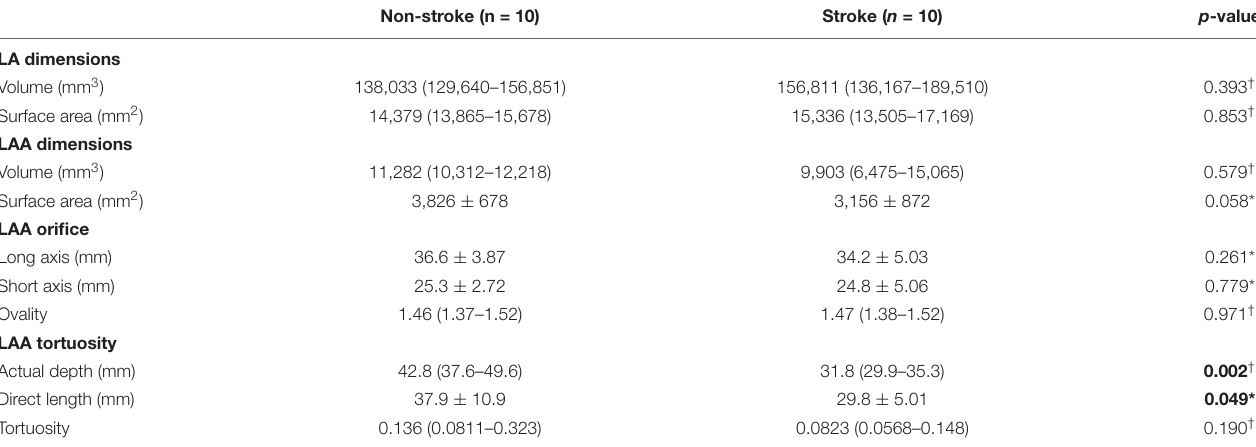
TABLE 2 | Morphological parameters.